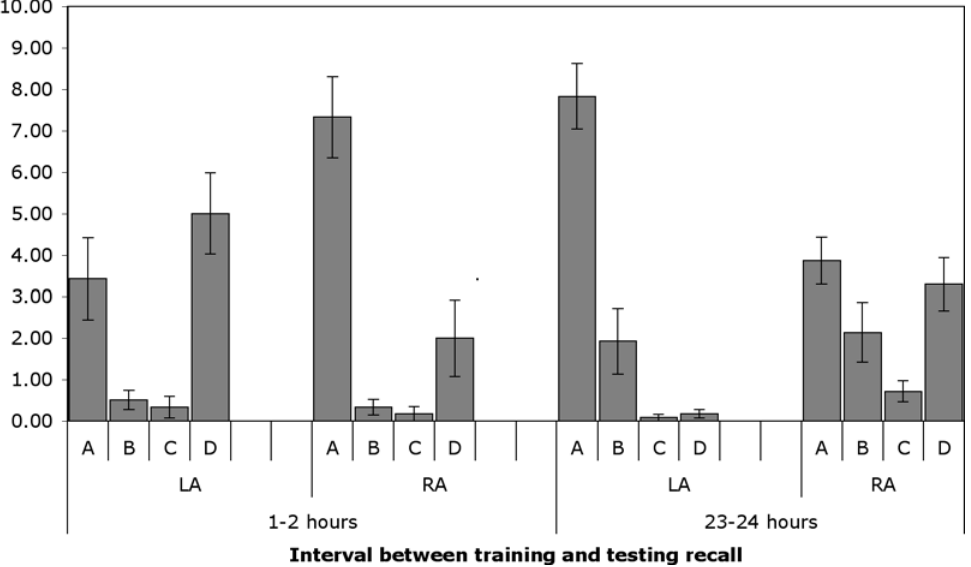
Figure 1. Experiment 1: Recall of memory at 1–2 and 23–24 hours after training. All bees were trained using both antennae and tested for recall using either the left (LA) or right antenna (RA), the other being covered with latex. The mean number ( 6 standard error) of type A responses (proboscis extension response, PER, to lemon odour and not vanilla odour), B (PER to both odours), C(PER to vanilla and not lemon) and D (no PER) are plotted. The A scores were analysed by GLM using the factors Antenna (left versus right antenna in use) and Order (left antenna tested first or right antenna tested first). At 1–2 hours after training, there was no significant main effect of Order (F(1,20)=2.896, p=0.104) and no significant interaction between Order and Antenna (F(1,20)=0.478, p=0.479). The main effect of Antenna was significant (F(1,20)=7.358, p=0.013). A responses were significantly higher when the right antenna was in use than when the left antenna was in use. At 23–24 hours after training, there was no significant main effect of Order (F(1,22)=0.124, p=0.728) and no significant interaction between Order and Antenna (F(1,22)=1.597, p=0.220). The main effect of Antenna was significant (F(1,22)=14.064, p=0.001). A responses were significantly higher when the left antenna was in use than when the right was in